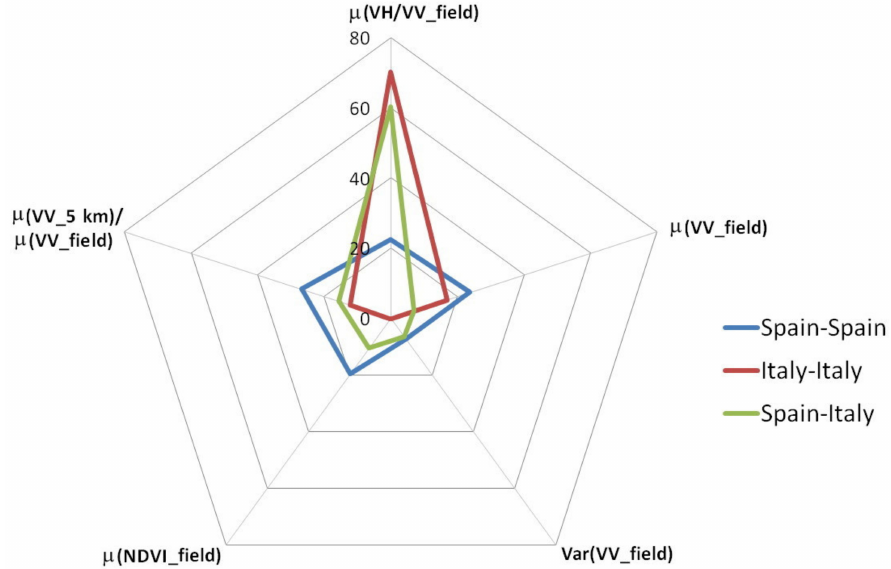
Figure 5. Contribution of the different metrics according to the classification